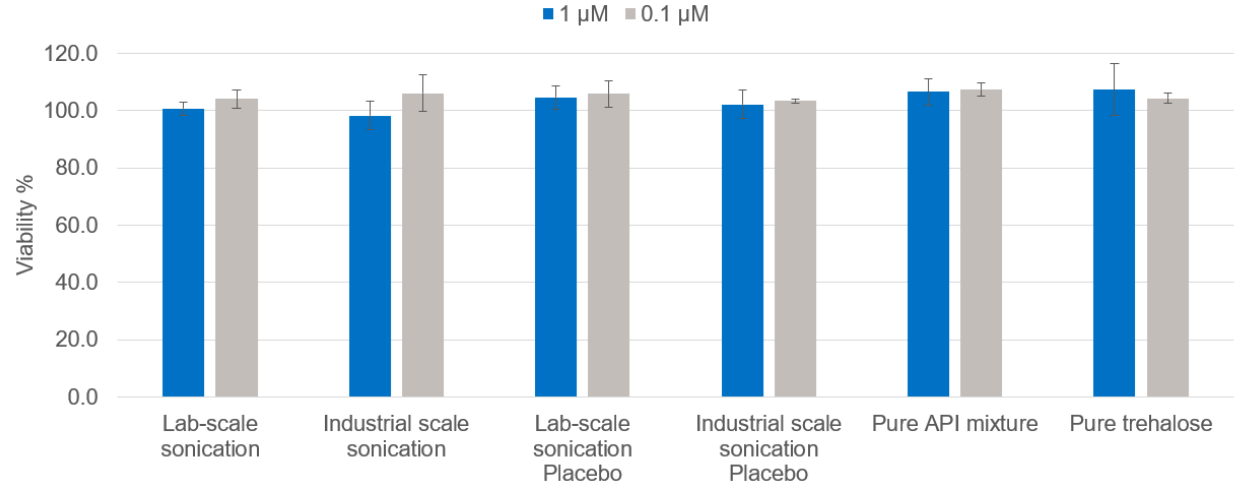
Figure 5. Viability of the THP-1 cells incubated with NY-ESO-1/IMM60 particles at different concentrations of the total peptide amount.